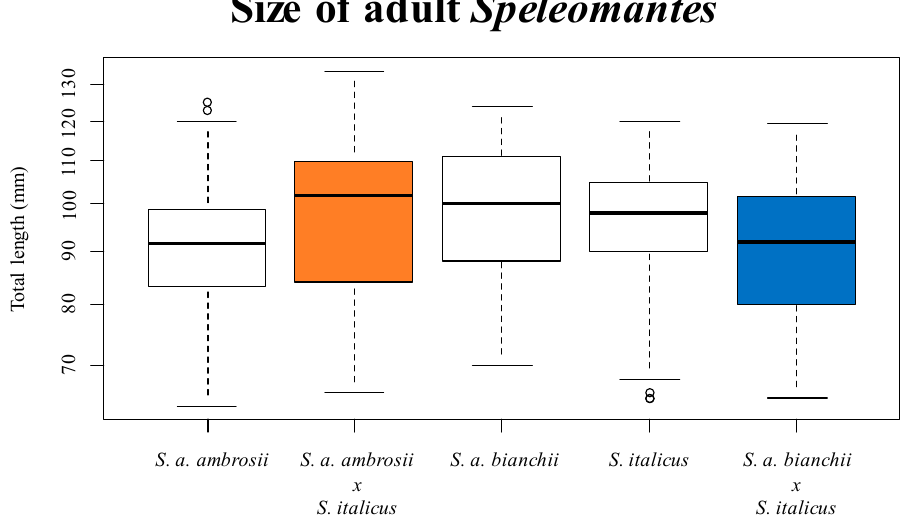
Figure 2. Boxplots showing the average size (TL) of adult Speleomantes considered in this study: S. a. ambrosii (163), S. a. ambrosii × S. italicus hybrids (28), S. a. bianchii (46), S. italicus (150), S. italicus × S. a. bianchii hybrids (125). The red box indicates introduced hybrids, blue natural hybrids, while in white the parental species.